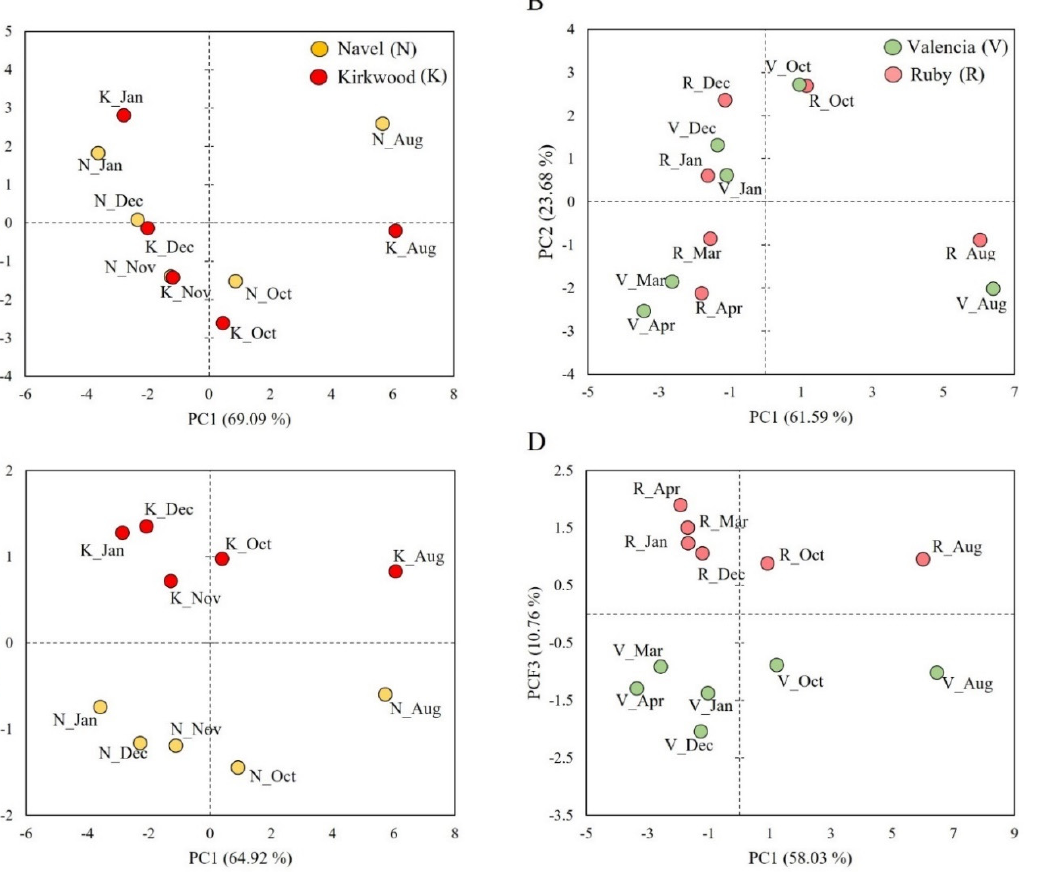
Figure 7. Principal component analysis (PCA) of the variables analyzed (vitamin C, tocopherols, total phenolics, total flavonoids, DPPH, FRAP, ABTS-H and ABTS-L) in Navel and Kirkwood oranges ( A ), and Valencia and Ruby oranges ( B ). Principal component analysis (PCA) of the variables analyzed and total carotenoid contents adapted from Zacar í as-Garc í a et al. [38], in Navel and Kirkwood oranges ( C ), and Valencia and Ruby oranges ( D ). Aug: August; Oct: October; Nov: November; Dec: December; Jan: January; Mar: March; Apr; April.